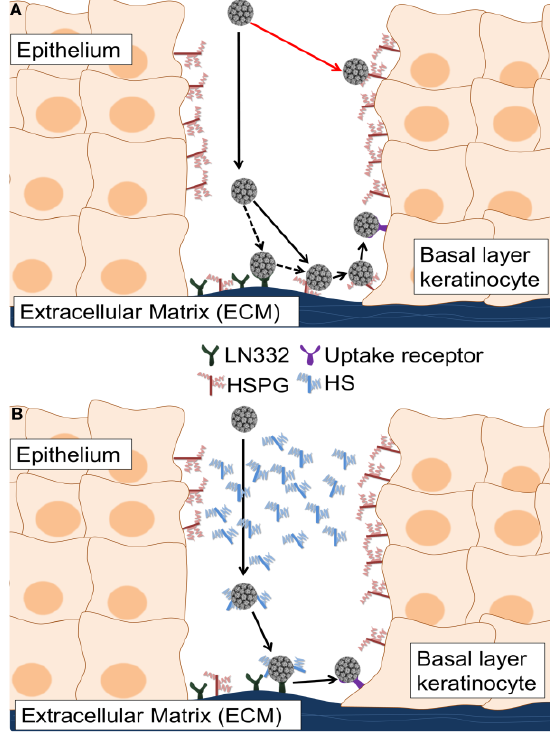
Figure 7. A model of HPV16 entry in the presence of soluble heparan sulfates. Infection with HPV occurs following a wounding event, which allows viral particles access to the basal layer of the epithelium. If the wound exudate is not taken into account, HPV infection would proceed as in the top panel ( A ); HPV would undergo unproductive interactions with suprabasal cell surface heparan sulfate (HS) and virus transit to the extracellular matrix (ECM) would be inefficient. Virus would bind to HS or